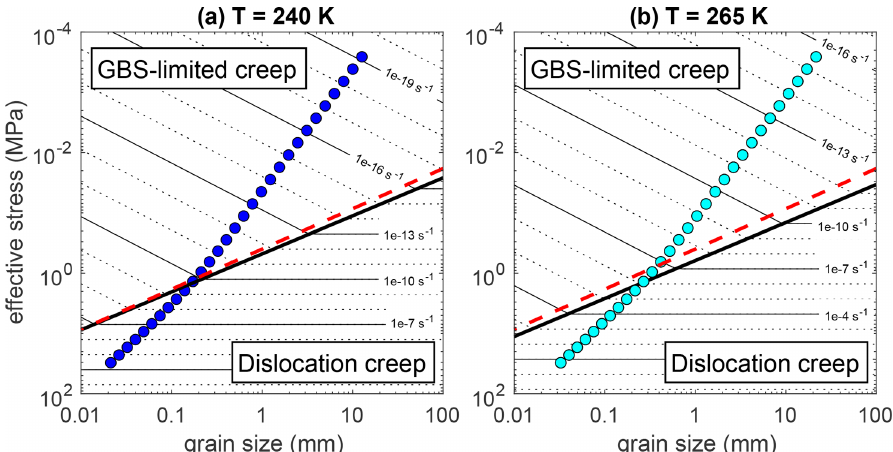
Figure 3. Effective stress vs. grain size at (a) 240K and (b) 265K calculated for a shear zone of fixed width using the wattmeter. Dark and light blue symbols correspond to the steady-state grain size predicted from a single model simulation at a given strain rate. Dashed red lines show location of the piezometer (Jacka and Li, 1994). Model results are overlain on a deformation mechanism map for ice calculated at the appropriate temperature using the flow law parameters from Goldsby and Kohlstedt (2001). Background contours correspond to strain rate; the thick black line indicates the boundary between GBS-limited creep (upper left) and dislocation creep (lower right). Under these conditions the location of the field boundary and piezometer are very similar.